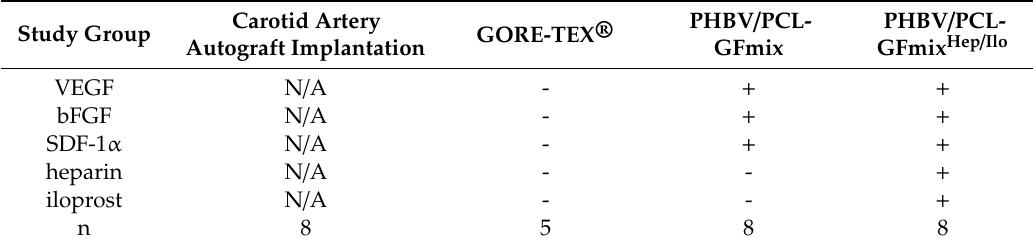
Table 2. Experimental groups of the